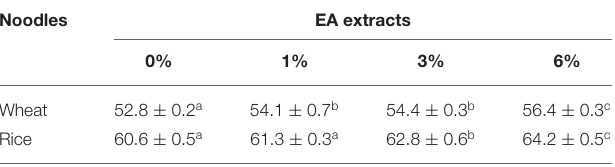
TABLE 2 | Moisture content of noodles incorporated with EA extract. Noodles